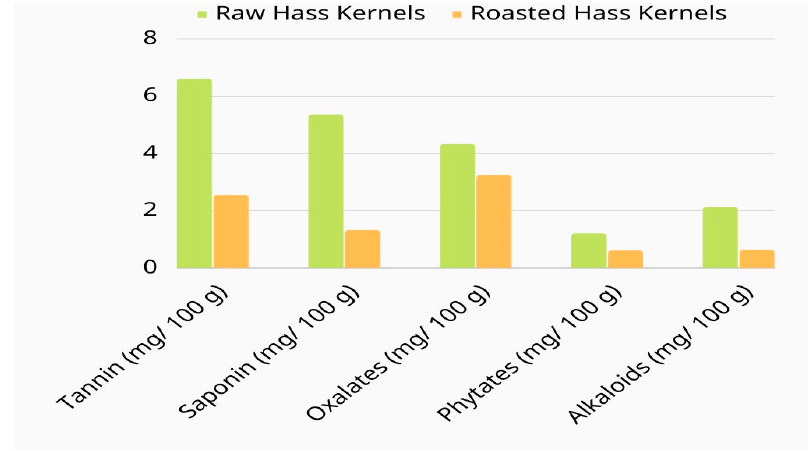
Figure 2. Antinutrients in raw and roasted Hass avocado kernels. Table 2. Browning index and colour characteristics in raw and roasted Hass avocado kernels. Degree